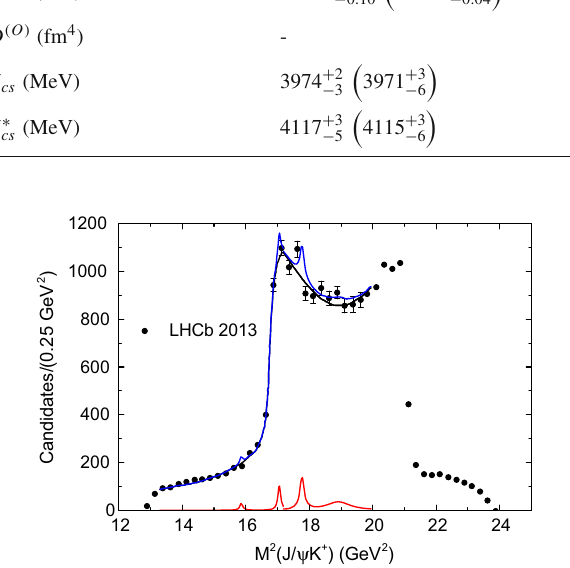
Fig. 3 The data of J /ψ K + spectrum in ¯ B 0 s → J /ψ K − K + at LHCb [60] and the possible contribution of Z cs (3985), Z ∗ cs (4130), Z cs (4220) and Z cs (4350). The red curves are Breit-Wigner (BW) distributions of those Z cs . Here the central values of mass and width from BESIII are used for Z cs (3985). The central values of mass from LHCb is used for Z cs (4220) with a width of 20.0 MeV. The mass and width of Z ∗ cs (4130) are respectively 4130 MeV and 15 MeV as expected by HQSS and SU(3)-flavor symmetry [5,29,47]. The mass of Z cs (4350) is quoted from hadro-quarkonium [13] and width 100 MeV is adopted. The blue solid curve is the incoherent sum of BW and simulated background mainly reflected from K − K + spectrum by